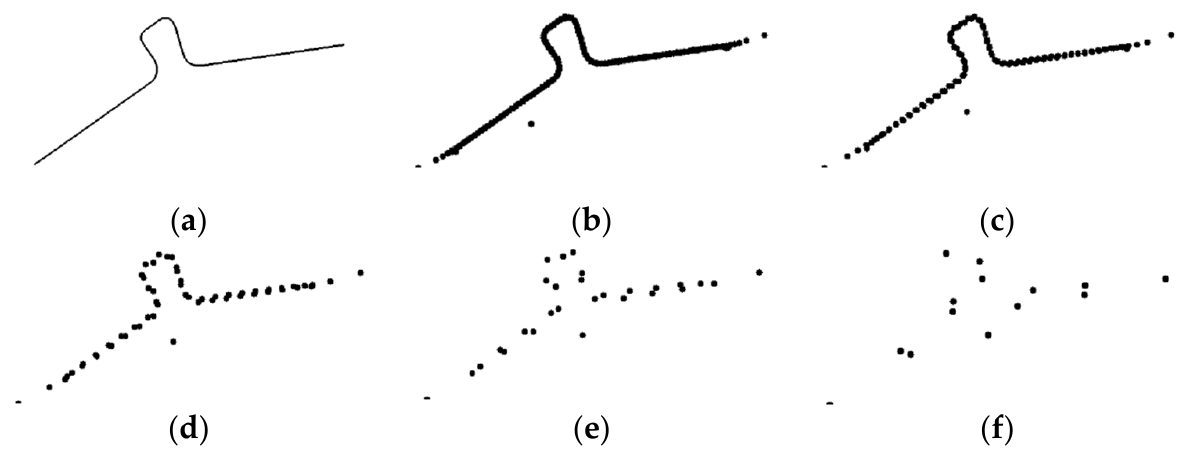
Figure 6. Contour reconstruction with different numbers of Fourier descriptors: ( a ) initial contour fragment, ( b ) 224 Fourier descriptors, ( c ) 112 Fourier descriptors, ( d ) 56 Fourier descriptors, ( e ) 28 Fourier descriptors, and ( f ) 14 Fourier descriptors.